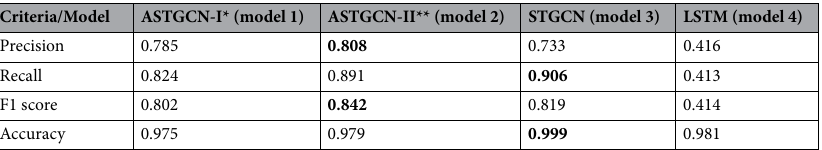
Table 2. Evaluation metrics for performance comparison of different models. Significant values are in [bold]. *ASTGCN with physic-based features. **ASTGCN with physic-based and human-sensed features.